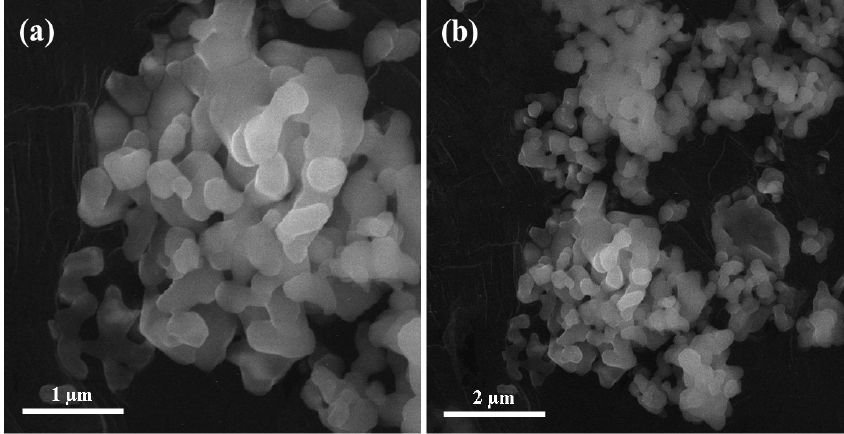
Figure 2. Scanning electron microscopy images of alumina nanoparticles at. ( a ) 50,000×, ( b )